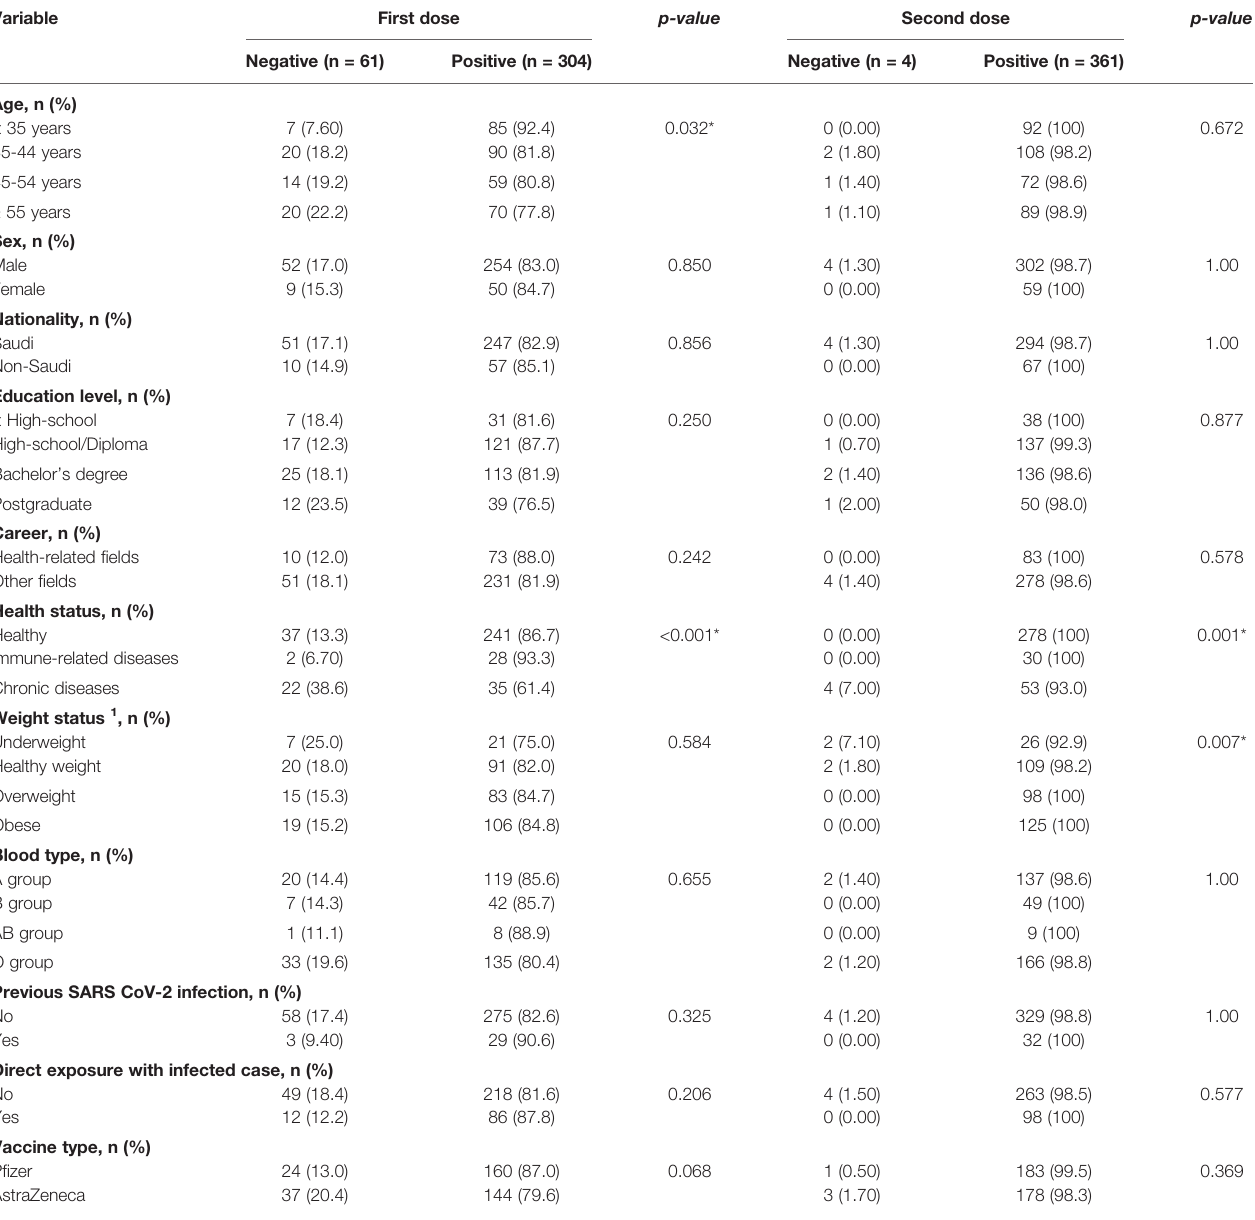
TABLE 3 | Associations between participants ’ characteristics and anti-S IgG antibody status (n = 365).